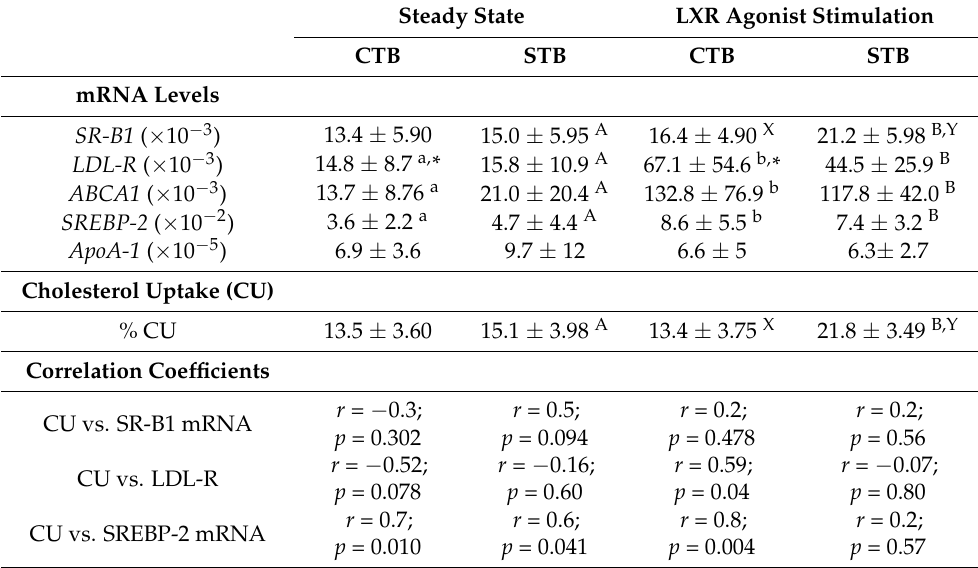
Table 2. Expression of selected cholesterol homeostasis genes and corresponding cholesterol uptake rates in CTB and